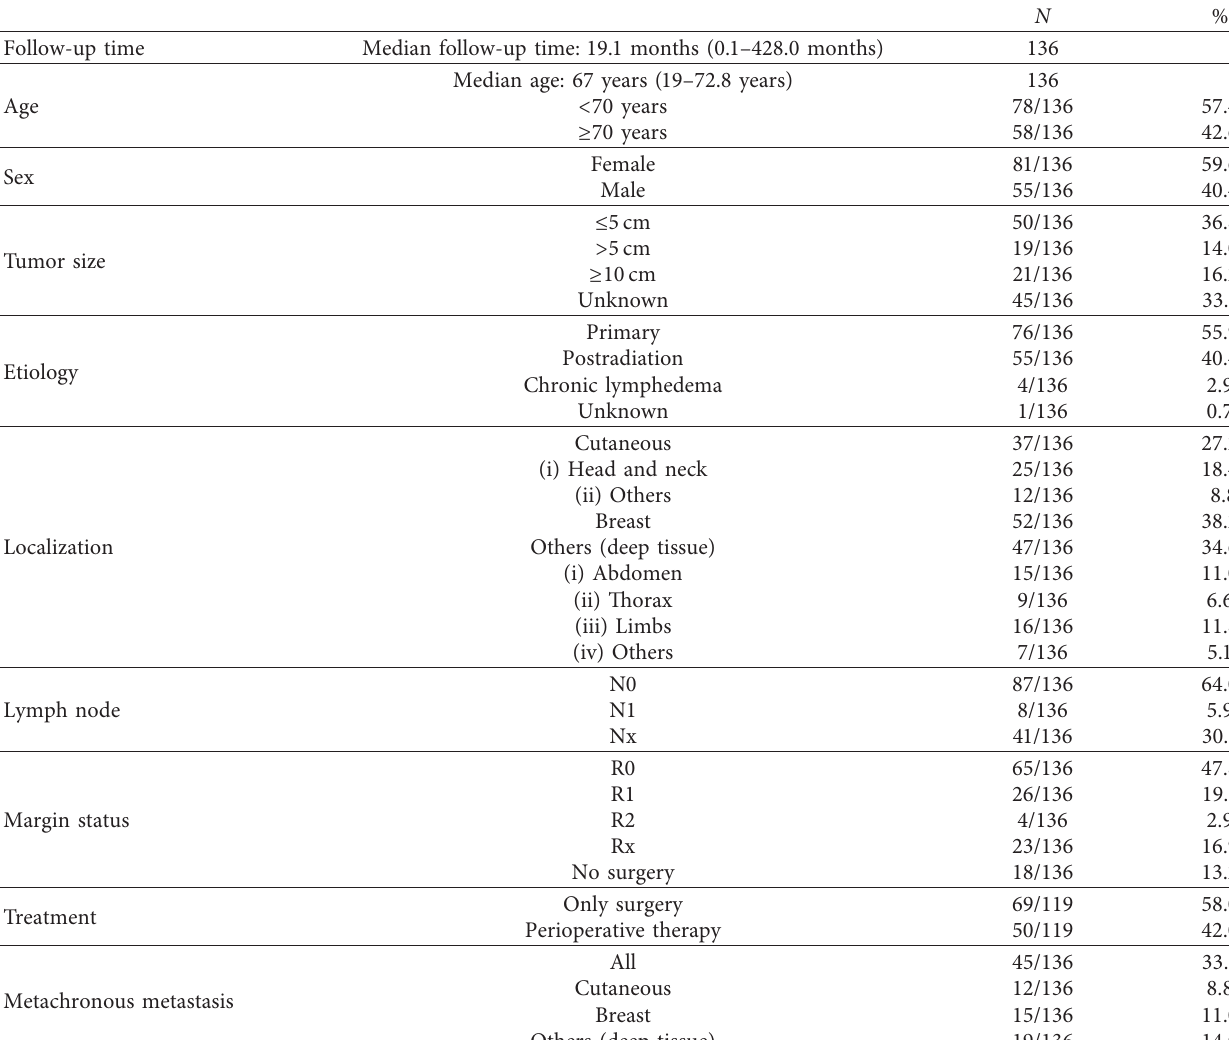
Table 1: Patient characteristics for the cohort of localized